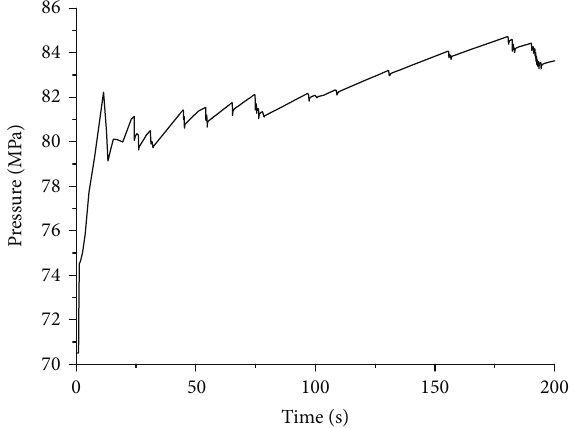
Figure 36: Pressure curve at the NF approaching angle of 60 ° and under a stress anisotropy coe ffi cient of